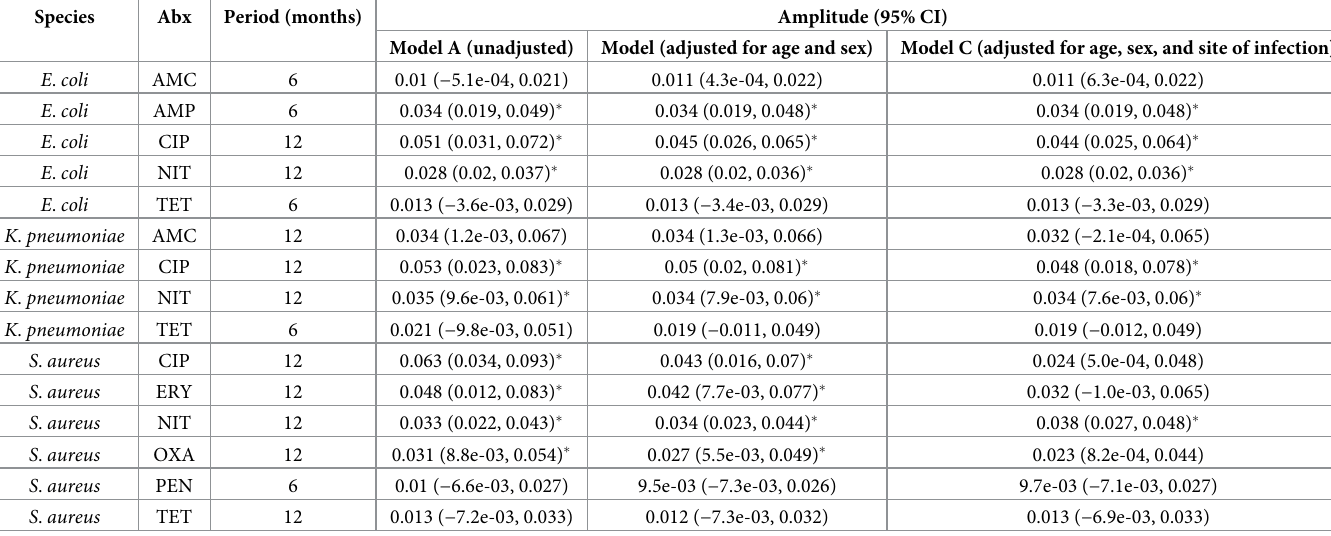
Table 1. Comparison of estimated amplitudes of seasonality across 3 sinusoidal models for resistance.